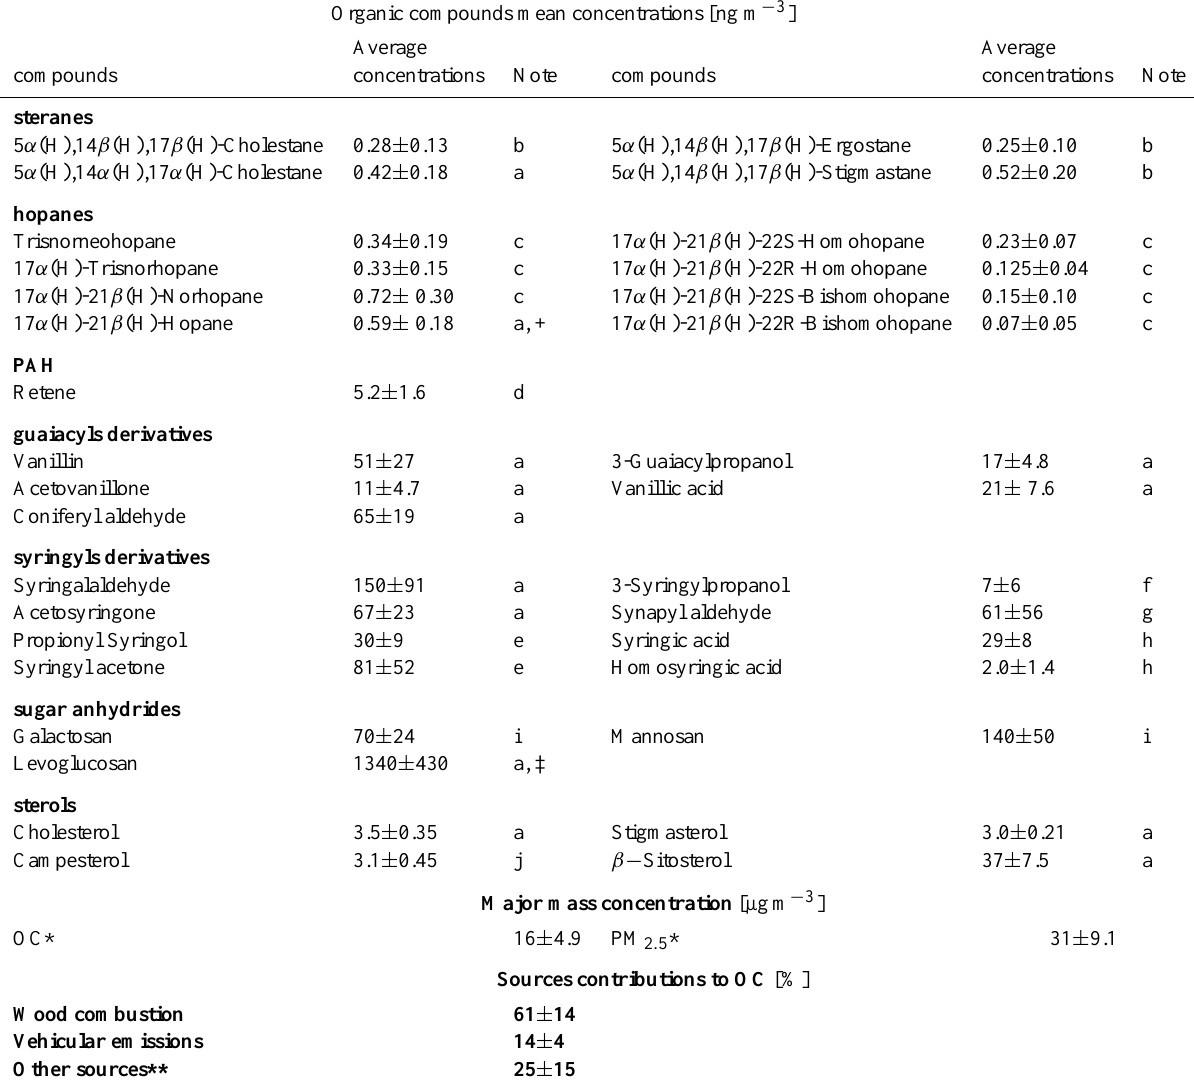
Table 4. Concentrations of organic tracers measured in the filter samples (average values, ngm − 3 ) collected in winter 2007 in Chamonix (France) and calculated contributions of wood combustion and road traffic emission sources (refer to text for the details of the contributions